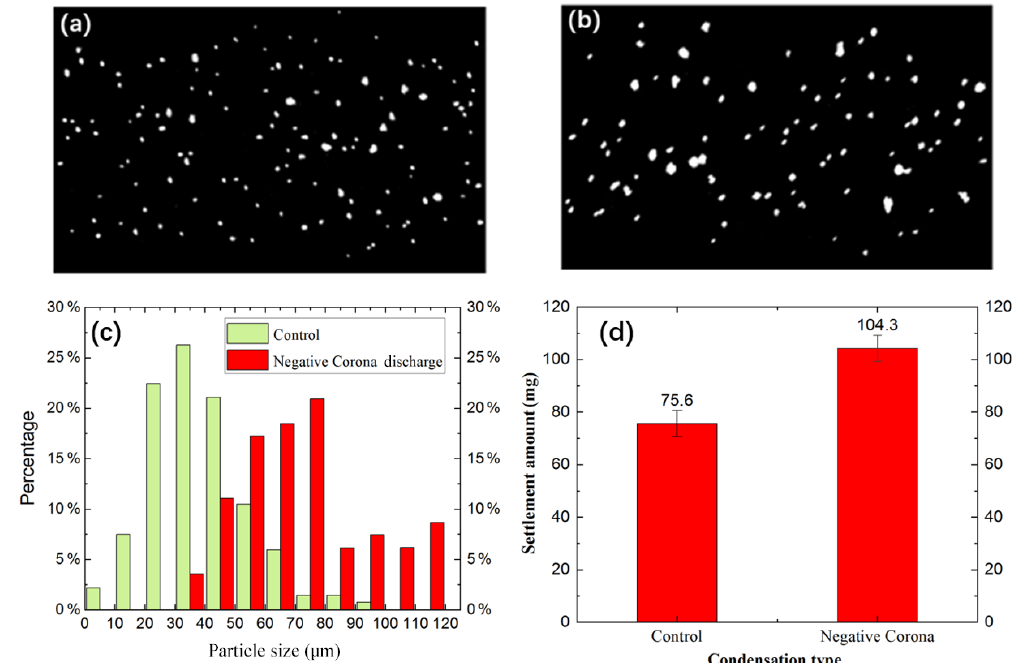
Figure 8. The ions generated by a corona discharge source enhance the condensation of aerosols. Shown here is a photo of aerosols in the light path of a laser for the case of the (a) control group and (b) the enhanced condensation group by ions. The photo was taken 5min after the experiment started. (c) The particle size distribution of aerosols in the cloud chamber for the control group and negative corona discharge group (calculated according to a and b ). (d) The ions generated by a corona discharge source enhance the settlement of moisture. The settlement of moisture for the control and negative corona discharge groups on the acceptor 10min after the experiment